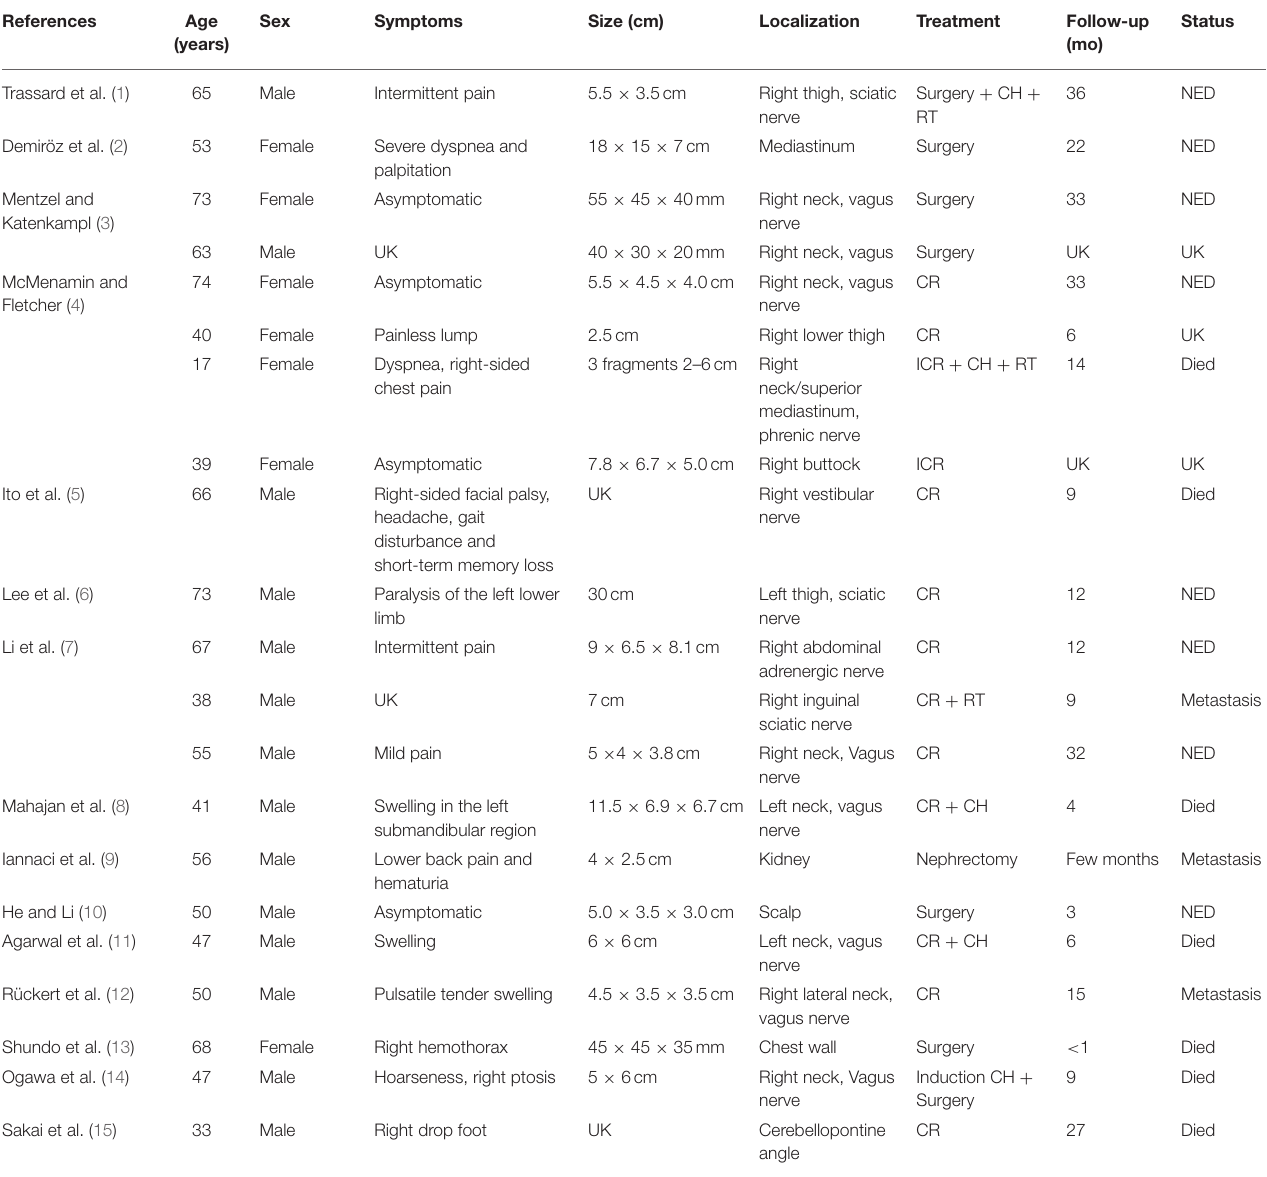
TABLE 1 | Cases of angiosarcoma arising in